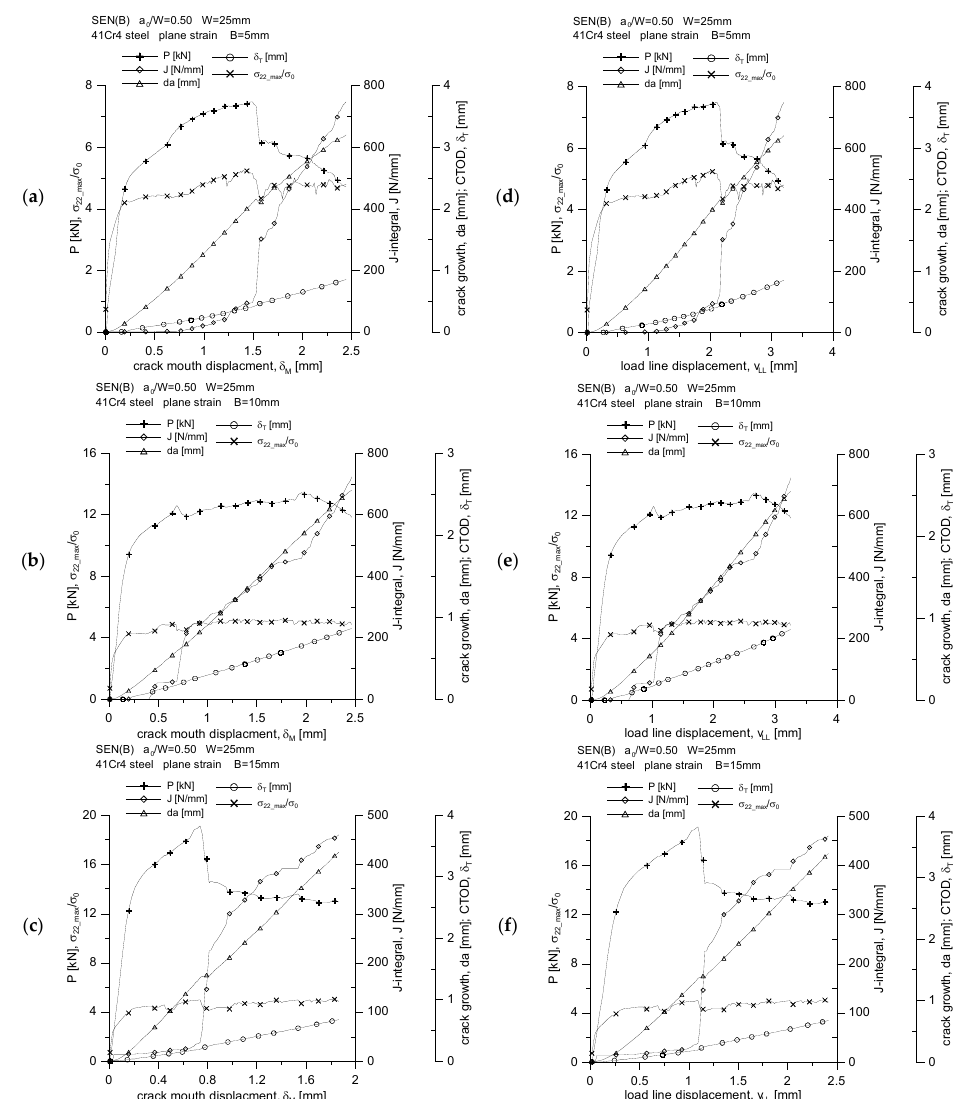
Figure 15. Changes of: the force, P, loading the specimen, the value of the J ‐ integral, the crack length increment, da , the crack tip opening displacement, δ T , and the maximum stresses opening the crack surfaces, σ 22_max / σ 0 , as a function of the crack mouth displacement, δ M ( a – c ), and as a function of load line displacement, v LL ( d – f ). When assessing changes in the basic fracture mechanics parameters, such as the J ‐ integral or the crack tip opening displacement, δ T , the relationship of both quantities with each other through the Shih relationship [14] and the relationship of the J ‐ integral with